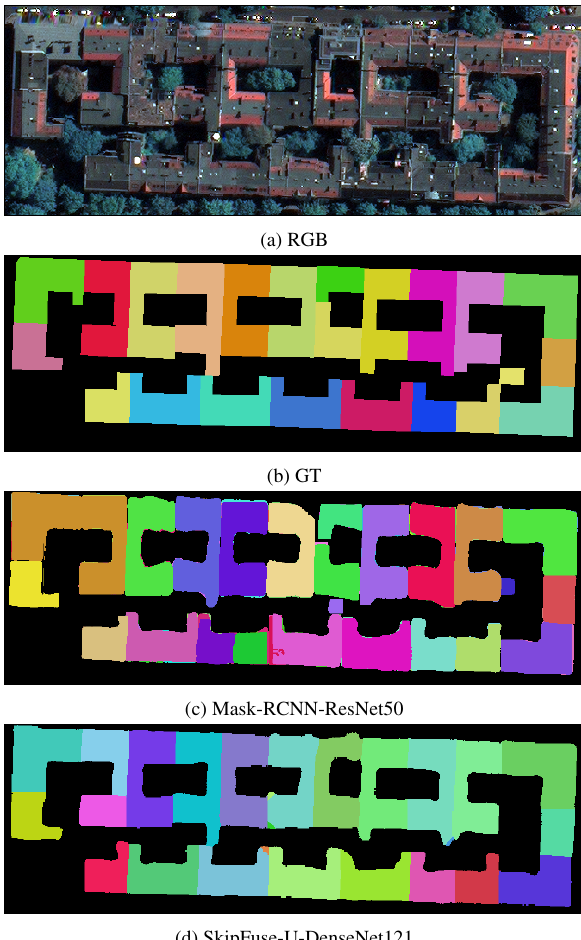
Figure 5. Comparison of the building section results of the (c) Mask-RCNN-ResNet50 trained on RGB and DSM and (d) the SkipFuse-U-DenseNet121 with the (a) RGB and (b) the ground truth. Each color represents a different building section.